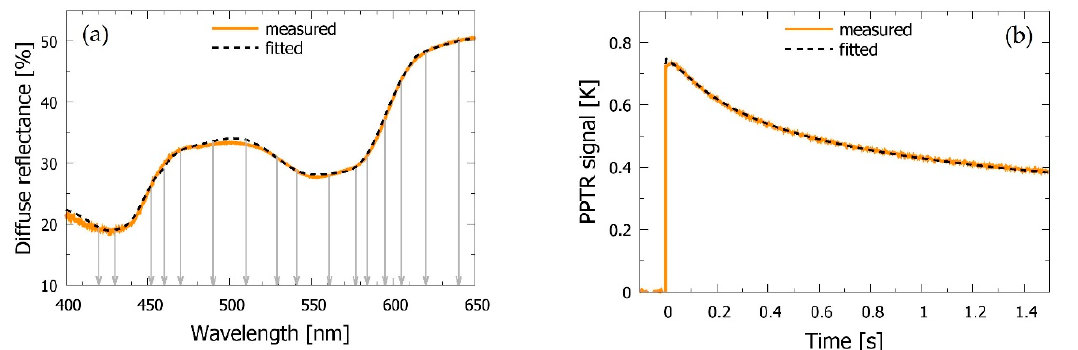
Figure 2. ( a ) Diffuse reflectance spectroscopy (DRS) spectrum and ( b ) pulsed photothermal radiometry (PPTR) signal as obtained from the intact skin site near the bruise in subject a (solid orange curves) and the best-fitting model predictions (dashed lines). Vertical gray arrows in ( a ) indicate the wavelengths included in the Inverse Monte Carlo (IMC) analysis of the DRS data.